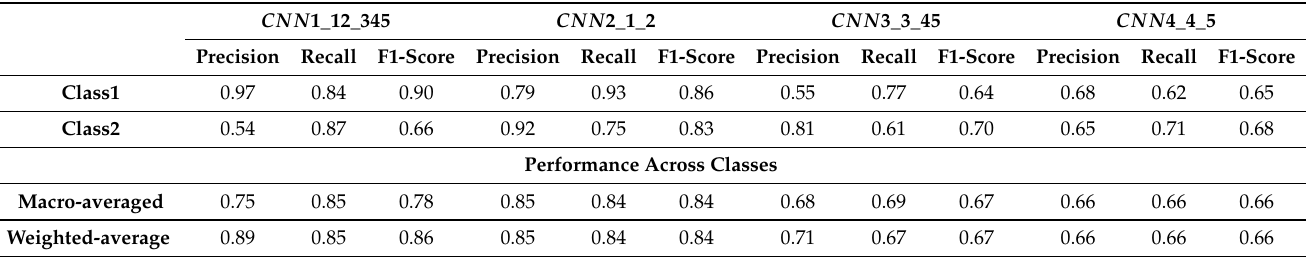
Table 3. Classification accuracy for the second level (75 × 75) of our proposed model, containing four CNNs.